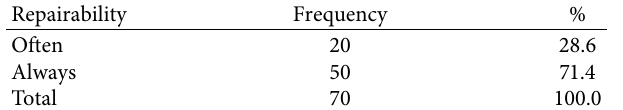
Table 17: Repairability.